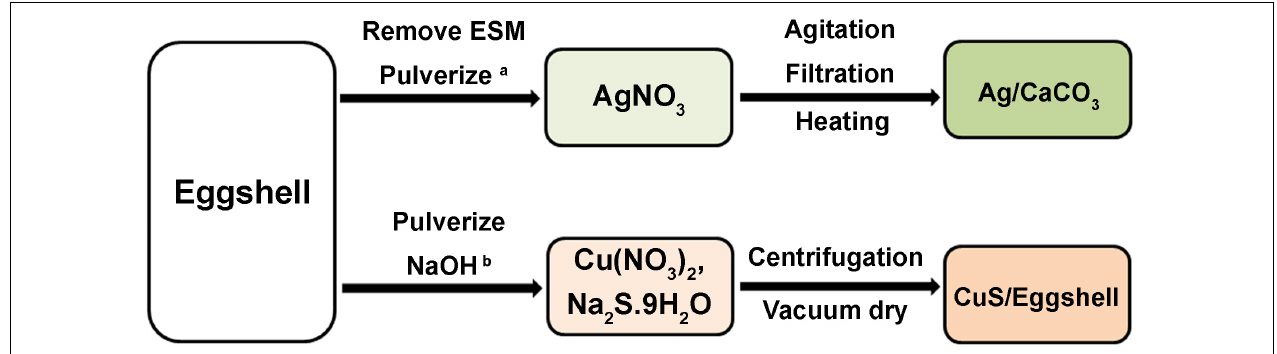
FIGURE 7 | Schematic presentation showing the production of ES-based nanoparticles. a: Ag/Eggshell (CN106862585A), and b: CuS/Eggshell (CN109809466A).